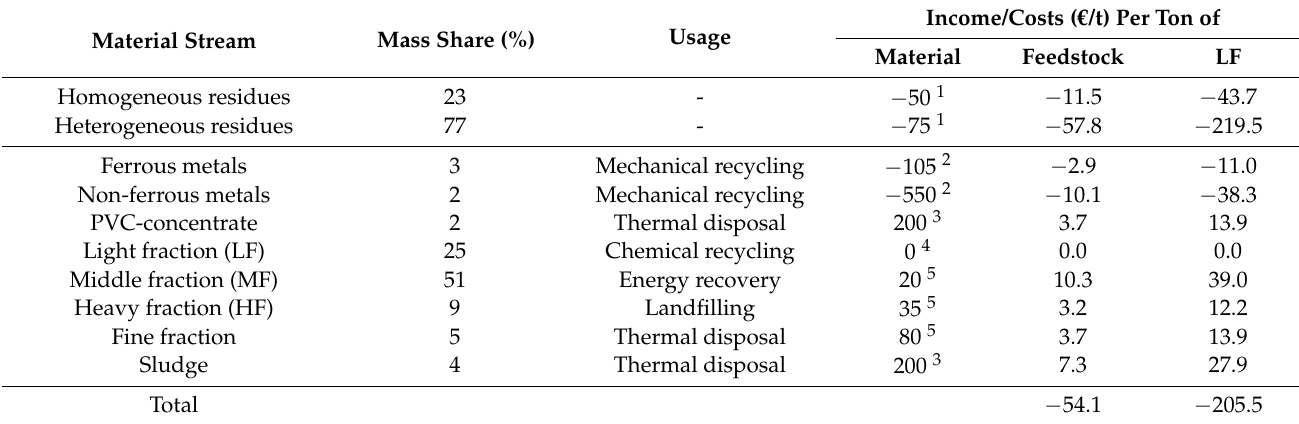
Table 19. Income and costs of the feedstock and produced main and